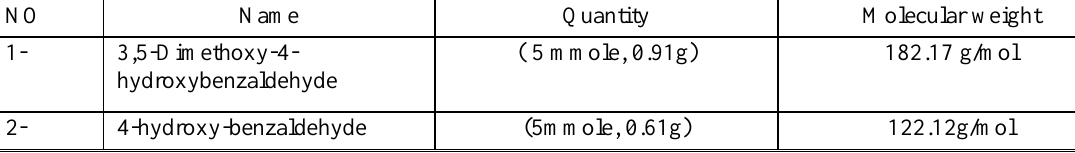
Table 1. Aldehydes used in synthesis of (H1,H2)